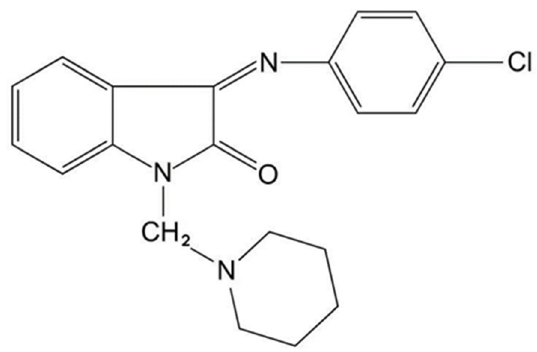
Figure 1. Chemical structure of Mb.